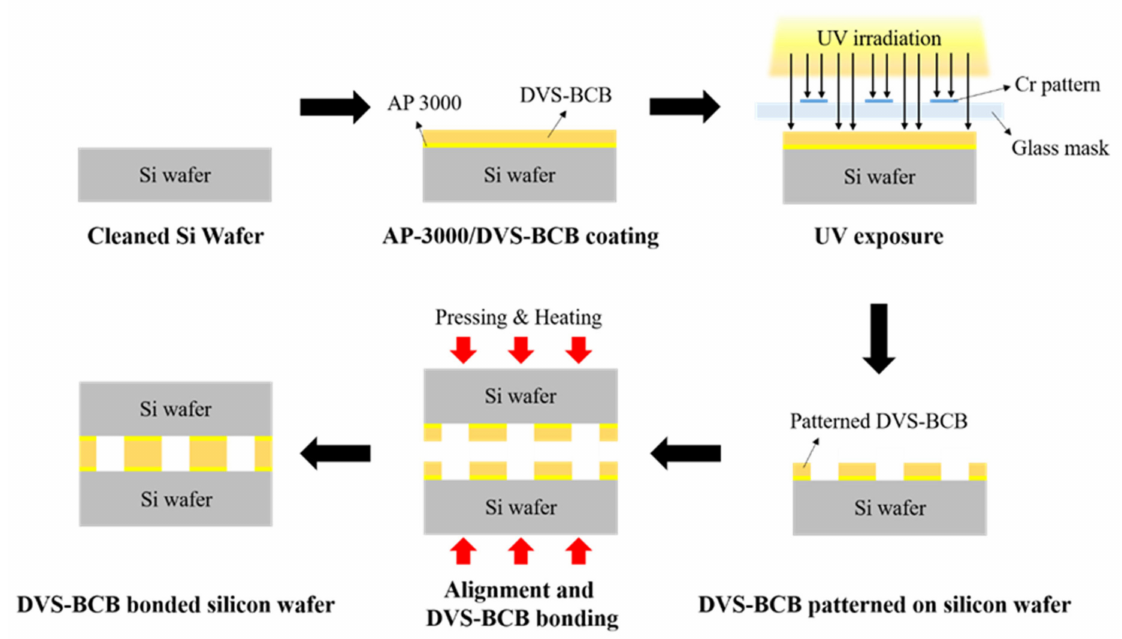
Figure 1. Schematic of the fabrication process for DVS-BCB